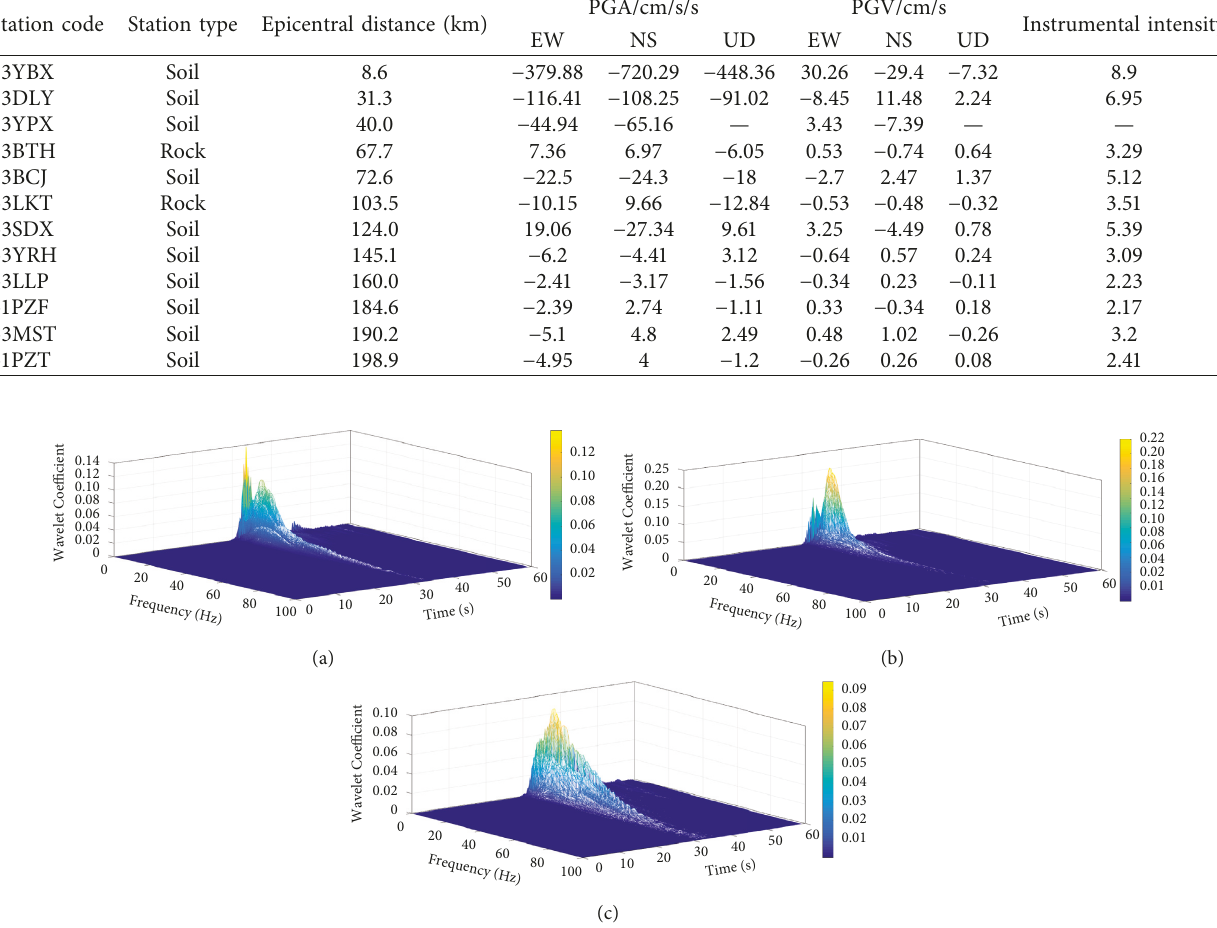
Figure 1: Wavelet time-frequency analysis of earthquake records at 53YBX: (a) east-west; (b) north-south; and (c)